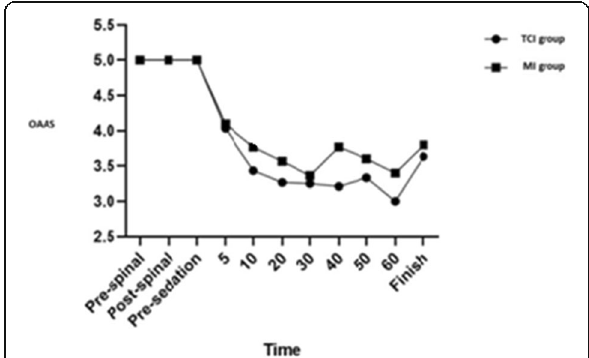
Fig. 8 Changes in anxiety scale. Values are mean ± SD